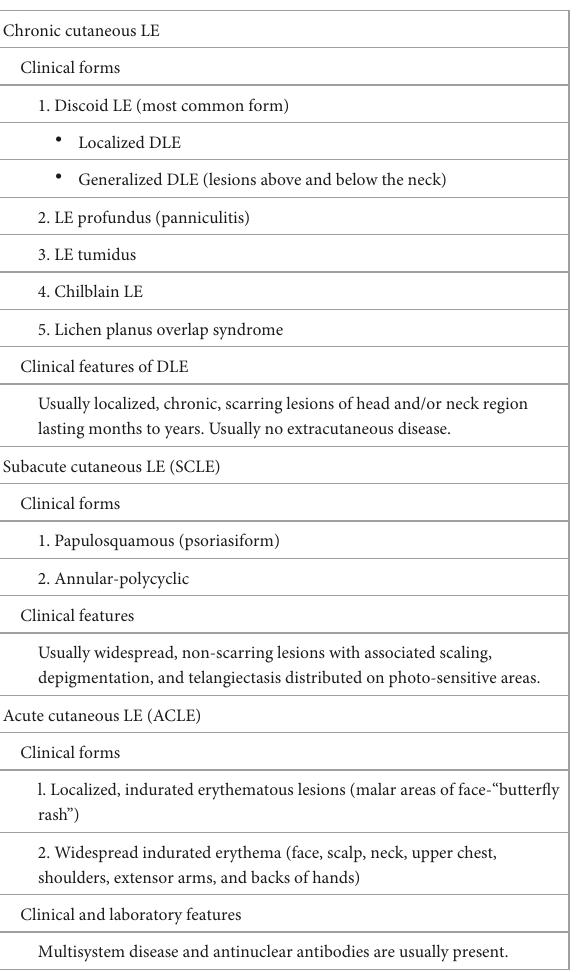
TABLE 1 Classification of cutaneous LE suggested by Gilliam and Sontheimer (3) (modified)